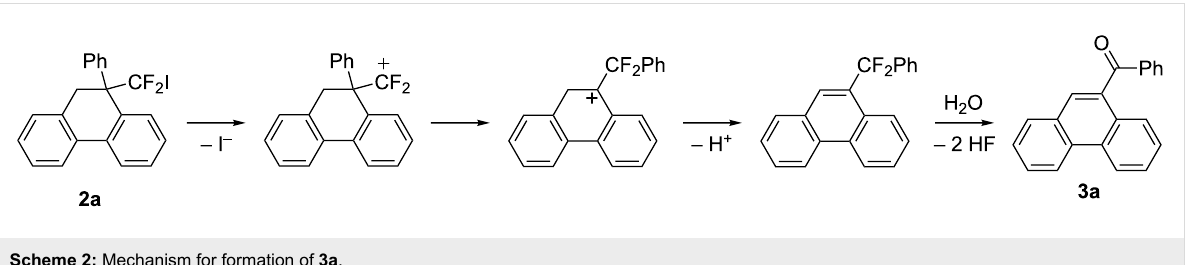
Table 2: Construction of six-membered carbocycles via iodoarylation of 1 .